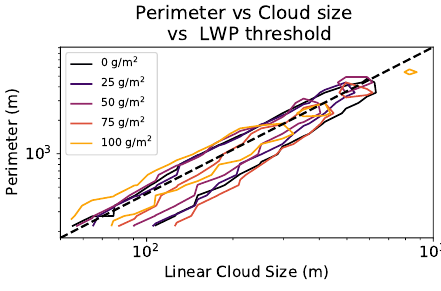
Figure 2. Linear cloud size vs. perimeter for different liquid water path thresholds. The slope of the best fit line signifies a fractal dimension of